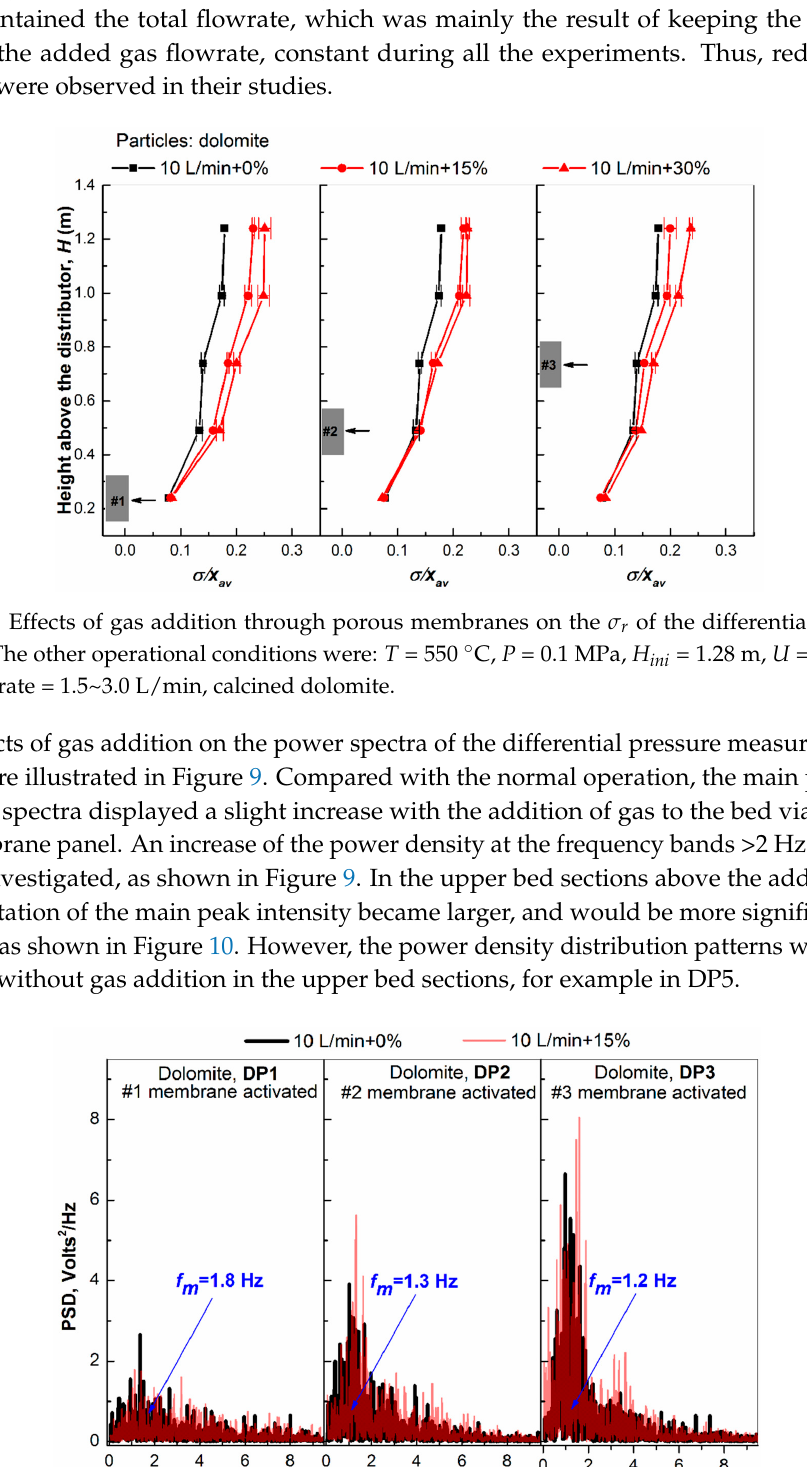
Figure 10. Effects of the gas addition location on the power spectra of the differential pressure measured at DP5. The other operational conditions: T = 550 °C, P = 0.1 MPa, H in i = 1.28 m, U = 0.09 m/s, addition rate = 1.5 L/min, calcined dolomite. The energy fraction profiles of the different level sub ‐ signals for the differential pressure signals measured at DP1 – DP4, with individually activated membrane #1 ‐ 3 for gas addition, are displayed in Figure 11. In the local bed section, gas addition would slightly decrease the energy fraction of the D7~D6 (0.39~1.56 Hz) and increase the energy fraction of the D4~D2 (3.125~25 Hz) level sub ‐ signals. No prominent change in the energy distribution of the differential pressure signals was observed in